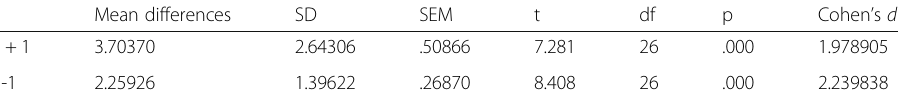
Table 7 Paired samples t-tests of both groups (reading comprehension pretest and posttest) Mean differences